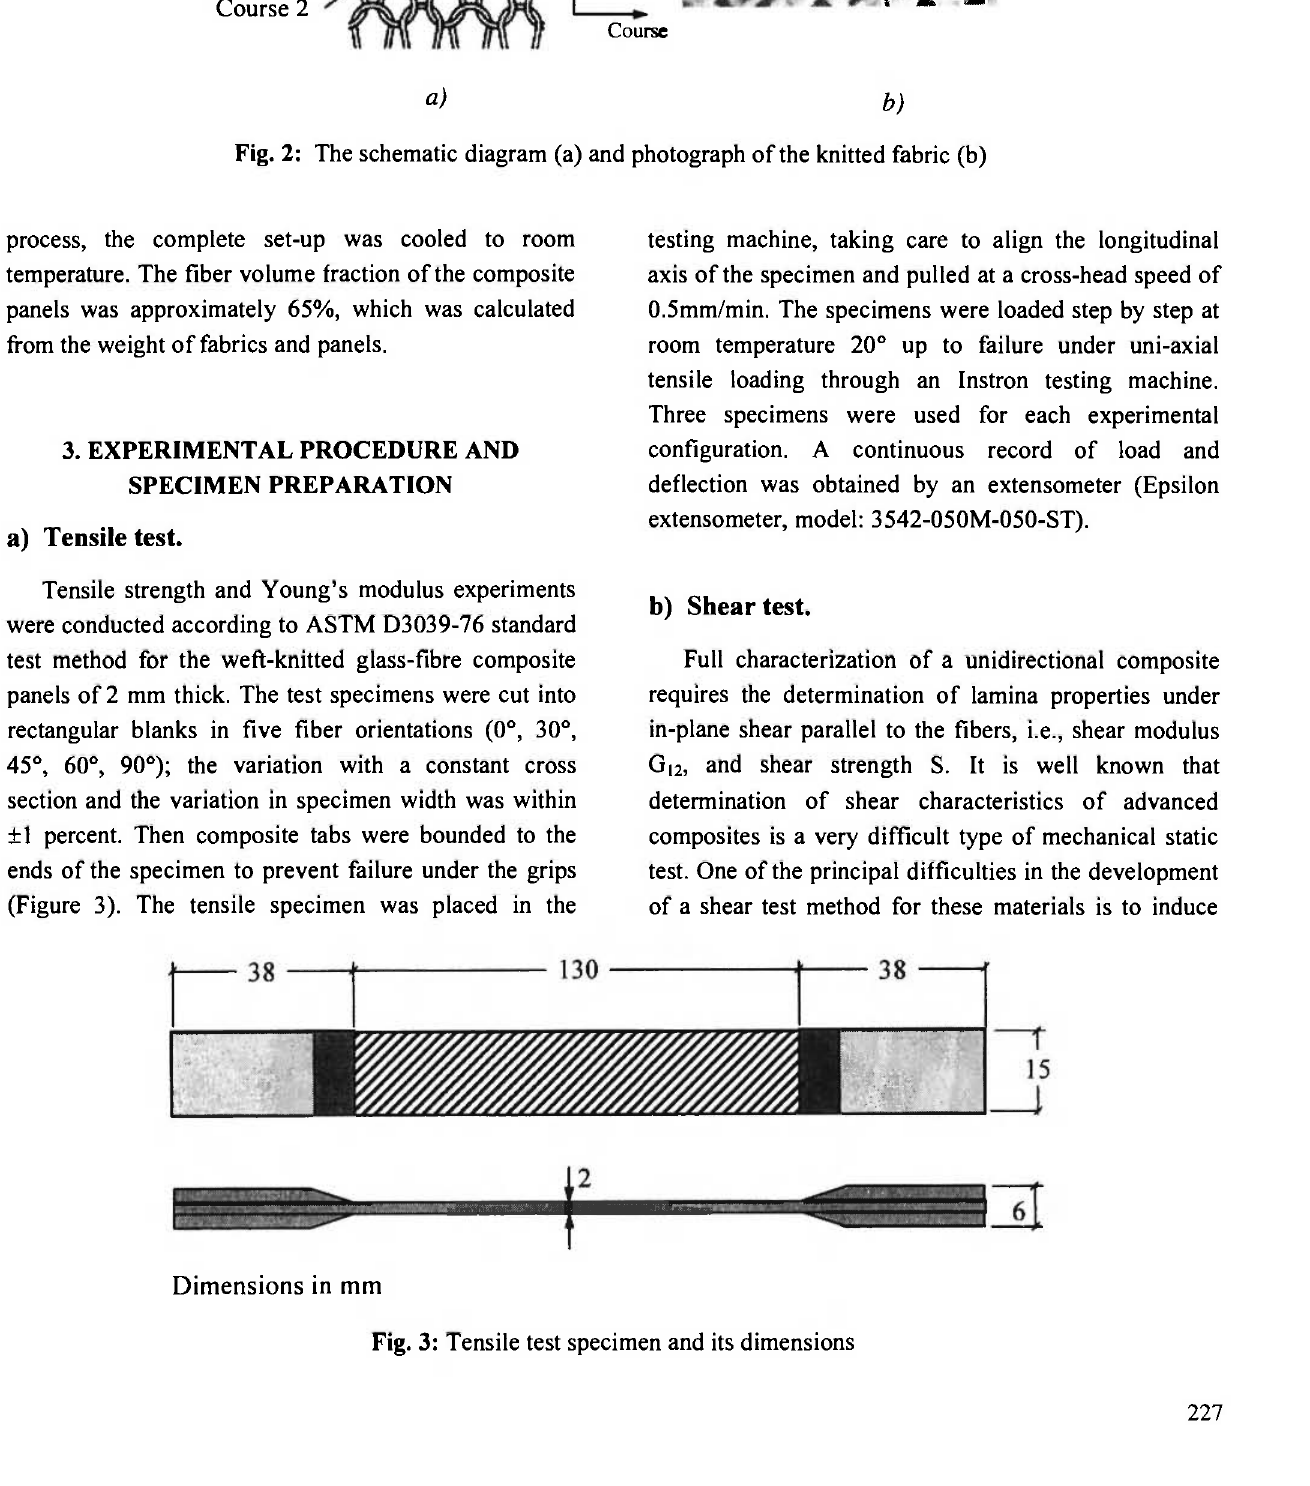
Fig. 3: Tensile test specimen and its